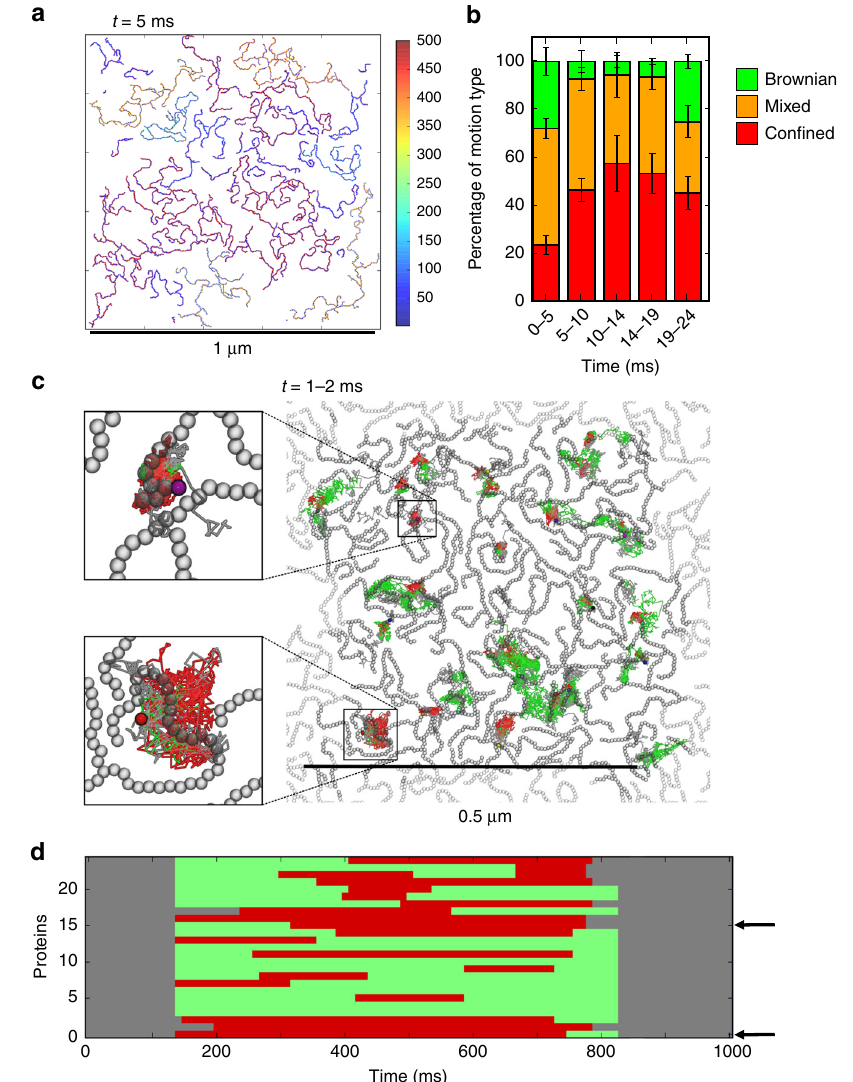
Fig. 7 Mesoscale simulations at experimental scales. a Snapshot of a 24 ms duration mesoscale simulation of a patch of membrane containing 4900 proteins in a 1 µ m 2 box at 5 ms. The patch dimensions correspond to those of an experimentally observed OMP island. The colour scale represents protein cluster size. b Fraction of different classes of diffusional motion (Brownian, green; con fi ned, red; or mixed Brownian and con fi ned, orange) for a random sample of 100 from the 4900 proteins in the mesoscale simulation as a function of time. Error bars show the standard deviation given by taking fi ve repeat resamples of 100 proteins. c Tracking over 1 ms of 25 inserted proteins. These were added to the mesoscale simulation in a after 1 ms, which was then allowed to run for a further 1 ms. The traces for the inserted proteins are coloured according to the motion type, as in b . The snapshot is from the fi nal frame (i.e. at 2 ms) with the 2500 original proteins in grey, and their periodic repeats in pale grey. The trajectories of the newly inserted proteins are shown in red (con fi ned) or green (Brownian). The upper inset shows a protein, which becomes part of a larger cluster and displays con fi ned motion whilst the lower inset shows a protein that remains monomeric but exhibits con fi ned motion as a result of being corralled by the pre-existing (in grey) cluster of proteins. d Classi fi cation of the diffusional motion of the 25 inserted proteins over the 1 ms simulation following their insertion. Colouring is as in c . (The grey blocks at either end of the trajectories are because the classi fi cations employ a sliding window, and therefore these points are unclassi fi ed.) Arrows indicate the two protein trajectories displayed in the insets in